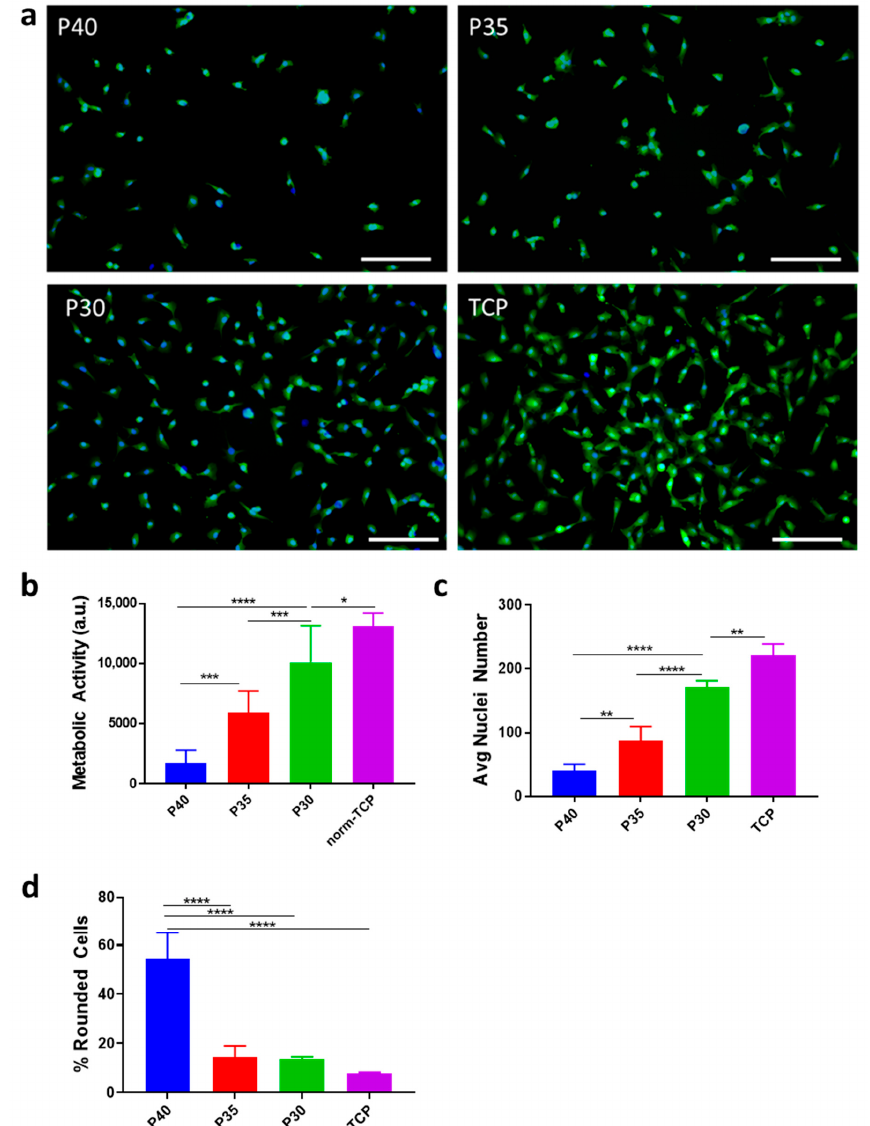
Figure 3. Cell adherence analysed 24 h after seeding on P40, P35, P30, and tissue culture plastic (TCP) surfaces. ( a ) Representative fluorescent images showing green fluorescence protein (GFP)-labelled mesenchymal stem cells (MSCs) (green) and Hoechst stained nuclei (blue). ( b ) Metabolic activity assay (norm-TCP shows activity for cells seeded onto TCP normalized to disc surface area). ( c ) Average nuclei count per field of view at 24 h. ( d ) Average percentage of rounded cells per field of view at 24 h. Scale bar = 250 μ m. a.u.: arbitrary fluorescence units. * p < 0.05, ** p < 0.01, *** p < 0.001 and **** p < 0.0001. ( n = 3).